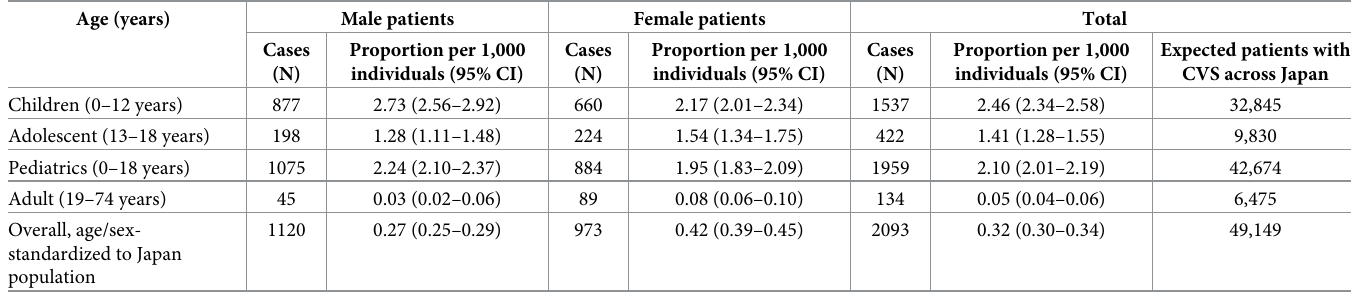
Table 2. Adjusted prevalence of patients with CVS by age and sex.